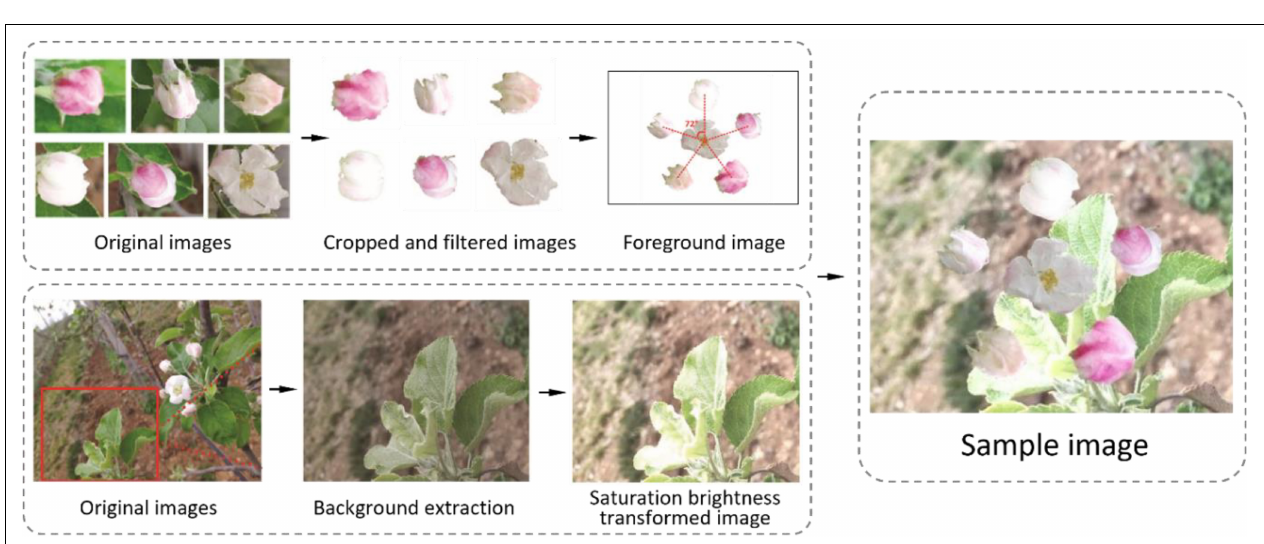
FIGURE 6 | Apple inflorescence: (A) the central flower and the side flowers have a bud shape, (B) the central flower has a semi-open shape and the side flowers have a bud shape, (C) the central flower has a fully open shape and the side flowers have bud and semi-open shapes, and (D) the central flower and the side flowers have a fully open shape.